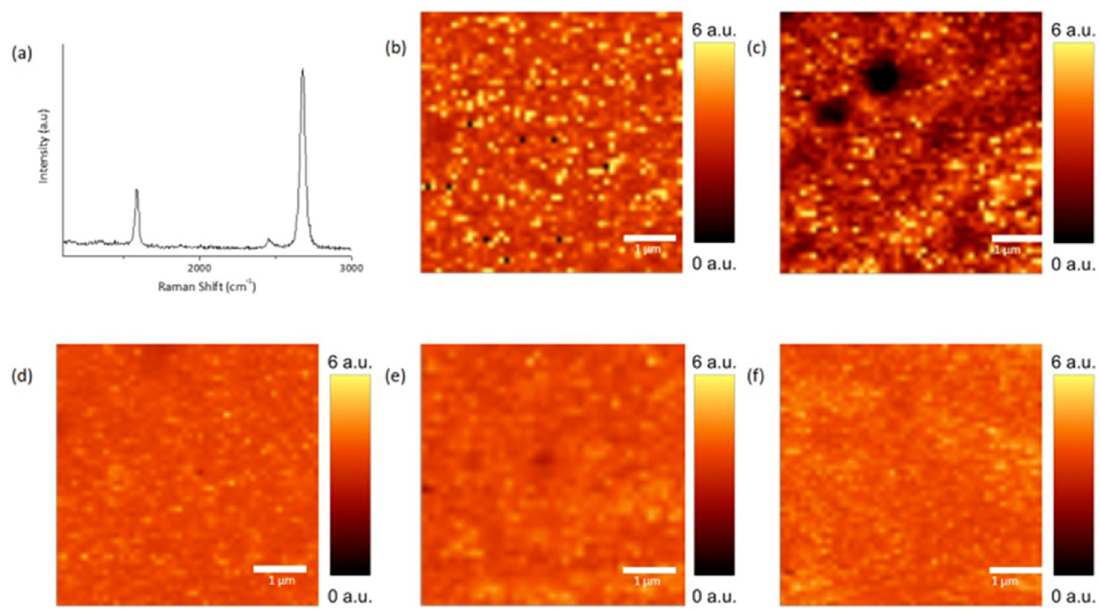
Figure 5. Raman spectra and mapping data after Graphene transfer. ( a ) Average Raman spectra of graphene showing predominately single layer graphene. ( b , f ) Raman mapping of 2D / G peaks after graphene transfer using ( b ) PMMA ( c ) Polystyrene ( d ) PS + Hexadiene ( e ) PS + Octadiene ( f ) PS + Decadiene.